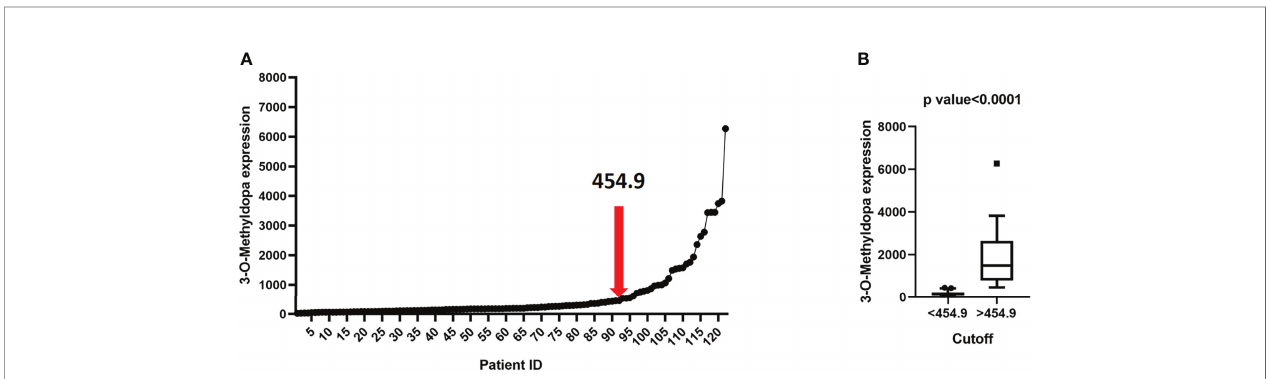
FIGURE 4 | 3-O-Methyldopa expression cutoff visualization. (A) Scatter plot reporting 3-O-Methyldopa expression in 122 NB patients. Cutoff, selected by the Elbow method, is reported within the plot. The relative rank position of the cutoff is shown by a red arrow. (B) Boxplot displaying the low or high 3-O-Methyldopa expression in 122 NB patients according to the cutoff value. Boxplot was visualized using Tukey ’ s method. Signi fi cance of the expression difference between low and high 3-O-Methyldopa expression was carried out by unpaired student ’ s t test. P value is reported on top of the